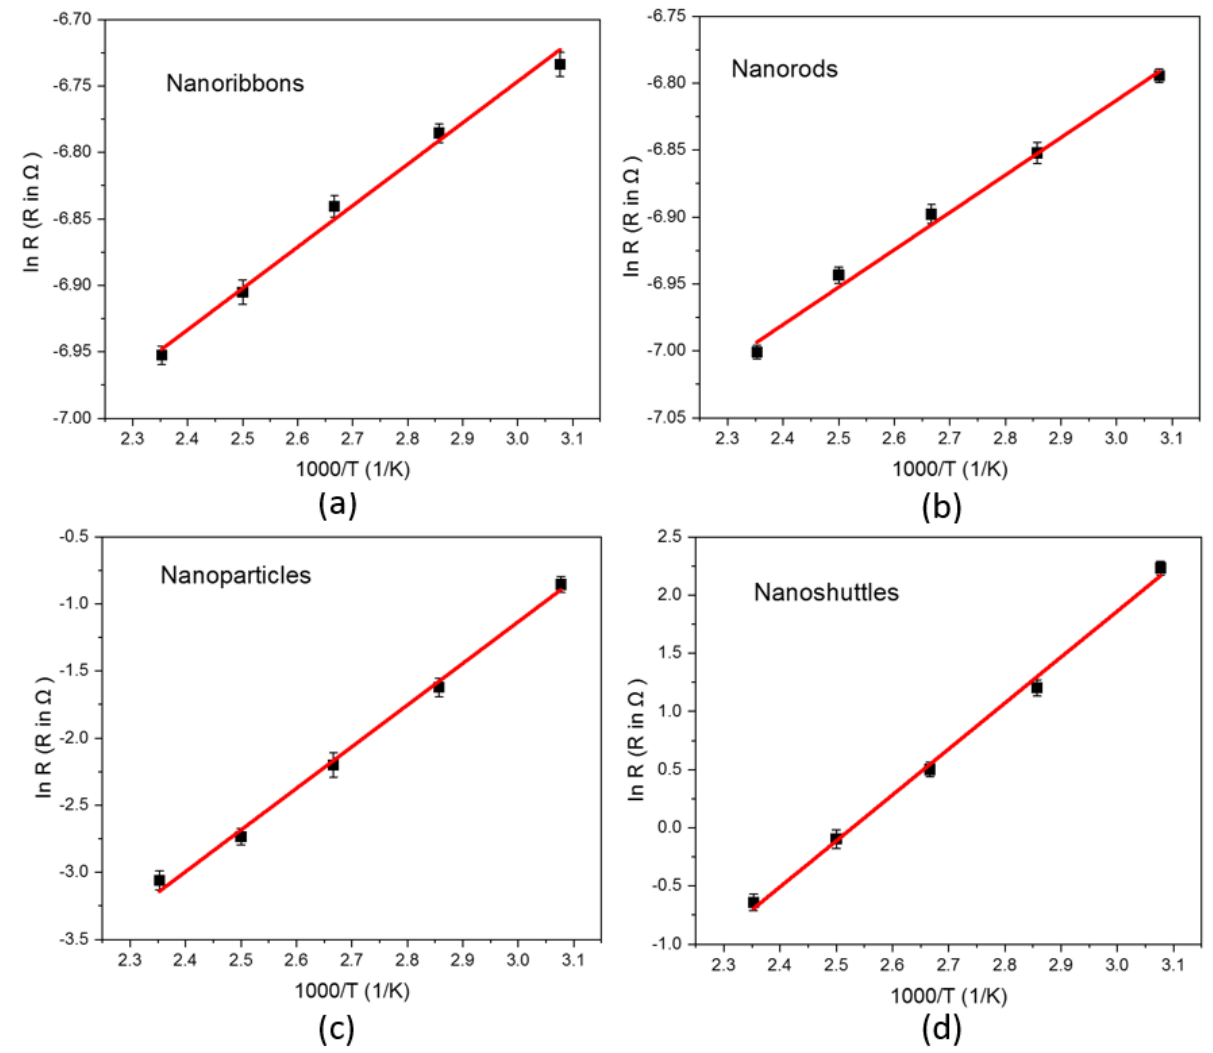
Figure 9. ln R versus 1000/T Arrhenius plot of ZnO nanostructures ( a ) nanoribbons, ( b ) nanorods, ( c ) nanoparticles, and ( d ) nanoshuttles. The red line indicates the linear Arrhenius plot. The dielectric spectra of each of the four ZnO morphologies are shown in Figure 10.